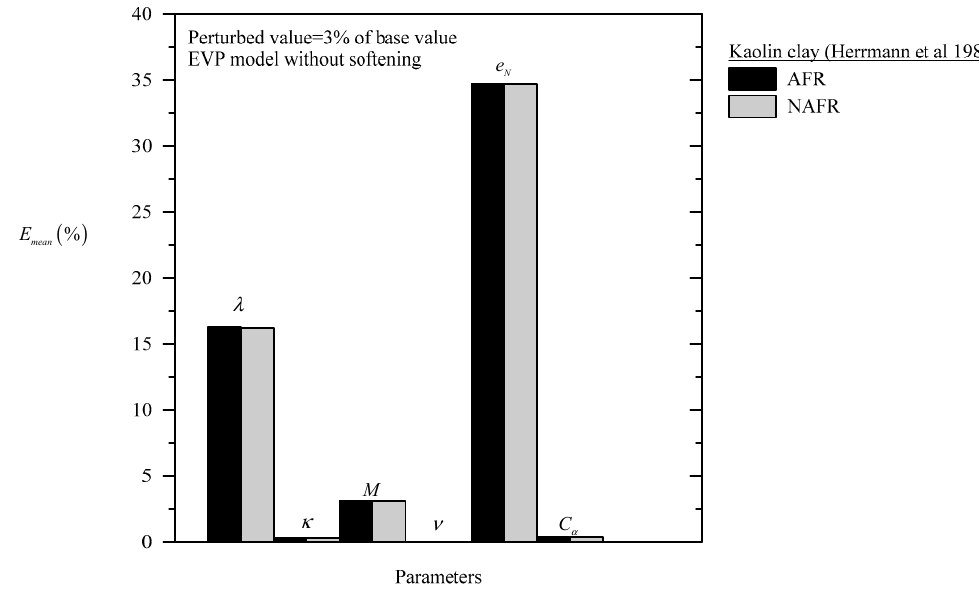
Figure 9. Sensitivity of perturbation for Osaka clay.